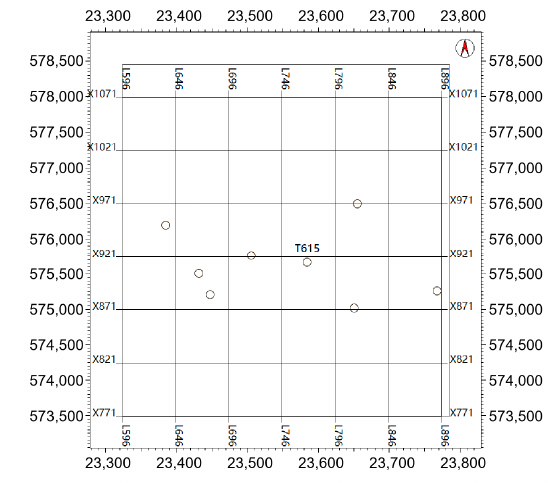
Figure 2. Distribution of the study area along two dimensions, i.e., inlines and xlines, where eight wells are marked by the dark circles.